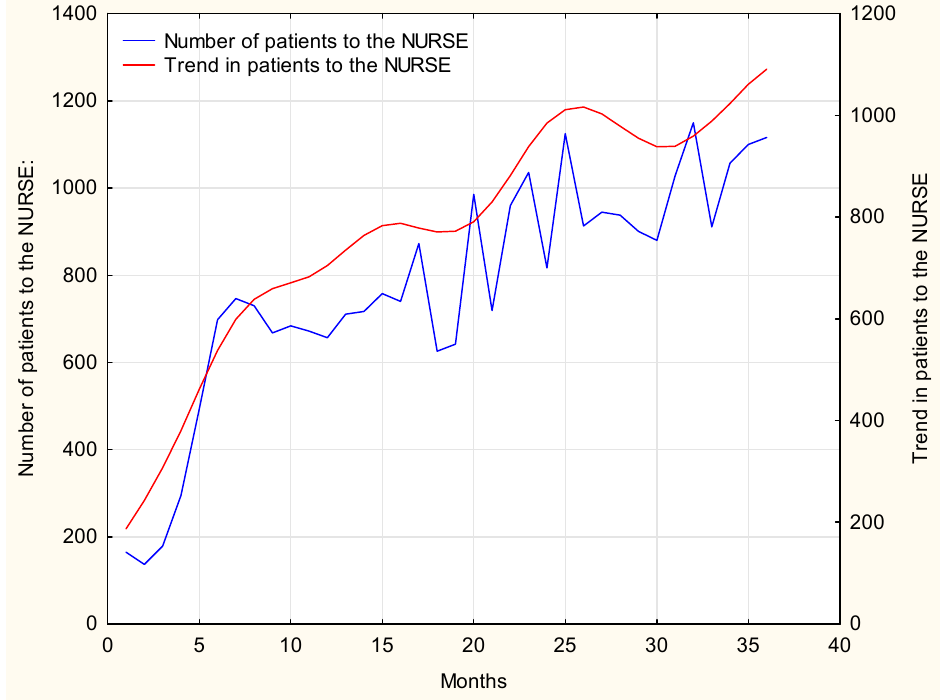
Figure 15. The number of patients visiting the nurse during the 36-month period, with a trend line.